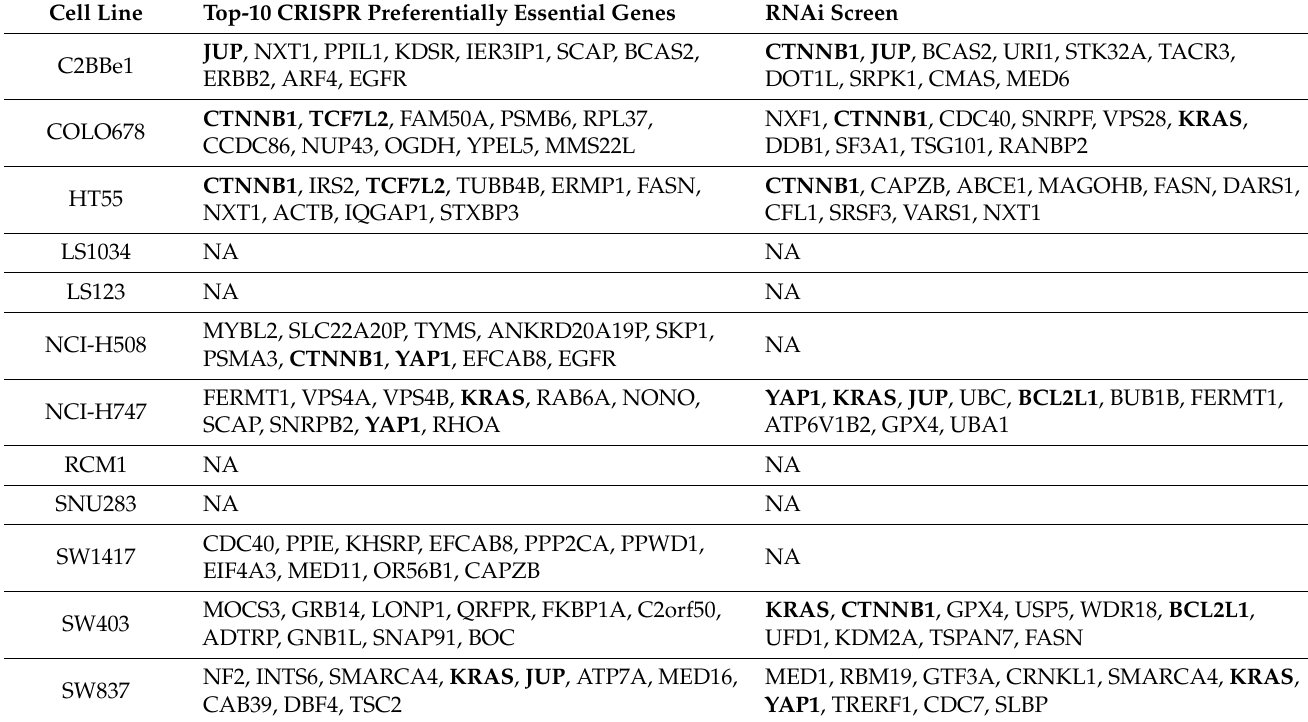
Table 6. CRISPR and RNAi dependencies of colorectal cancer cell lines with 20q11.21 amplification. CRISPR data are from CRISPR (Avana) Public 21Q1 screen and RNAi data are from a combined dataset from Board Institute, Novartis and Marcotte et al. [20], as compiled in the Cell Model Passports site (cellmodelpassports.sanger.ac.uk, accessed on 6 April 2021). NA: Not available. Recurrent genes are in